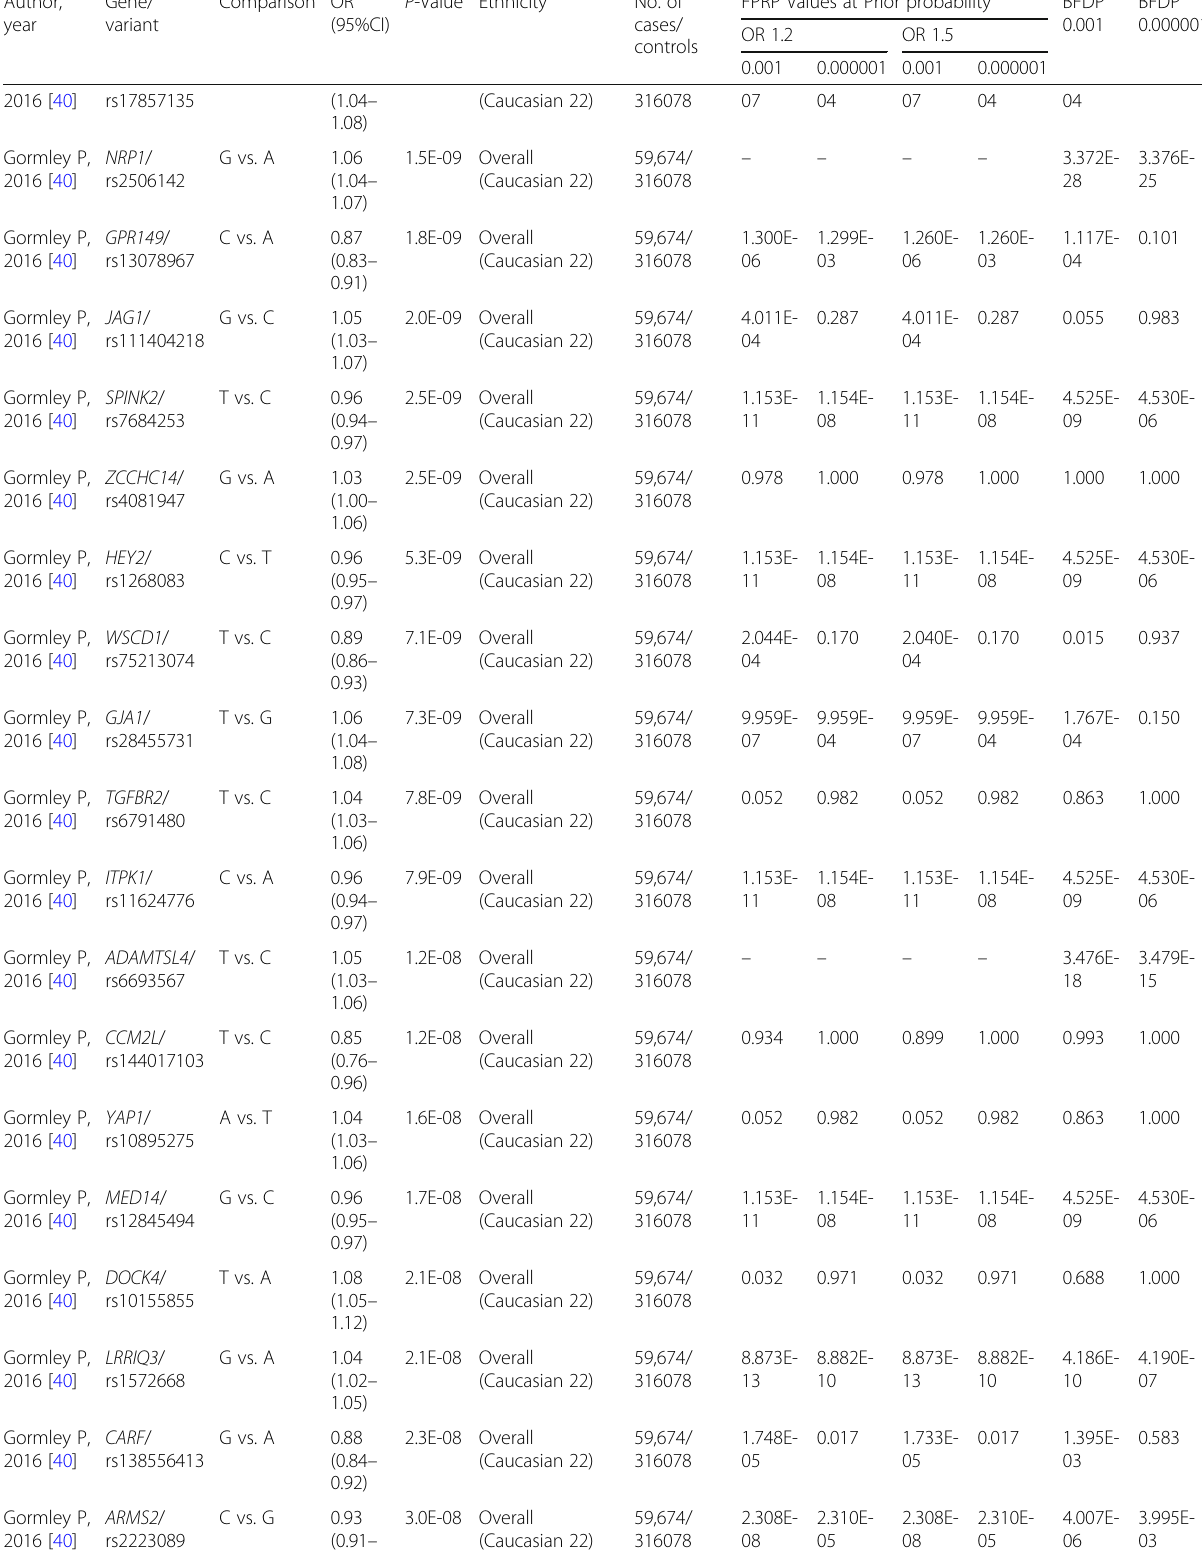
Table 2 Meta-analyses results of genetic variants with statistically significance ( P -value< 5*10 − 8 ) from GWAS